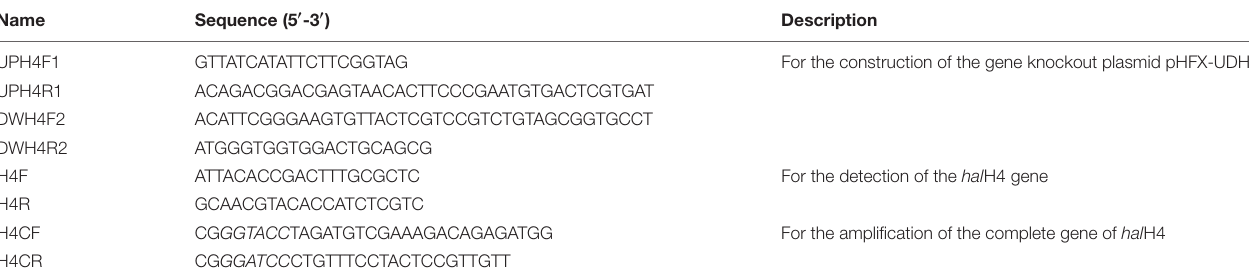
TABLE 2 | Oligonucleotides used in this